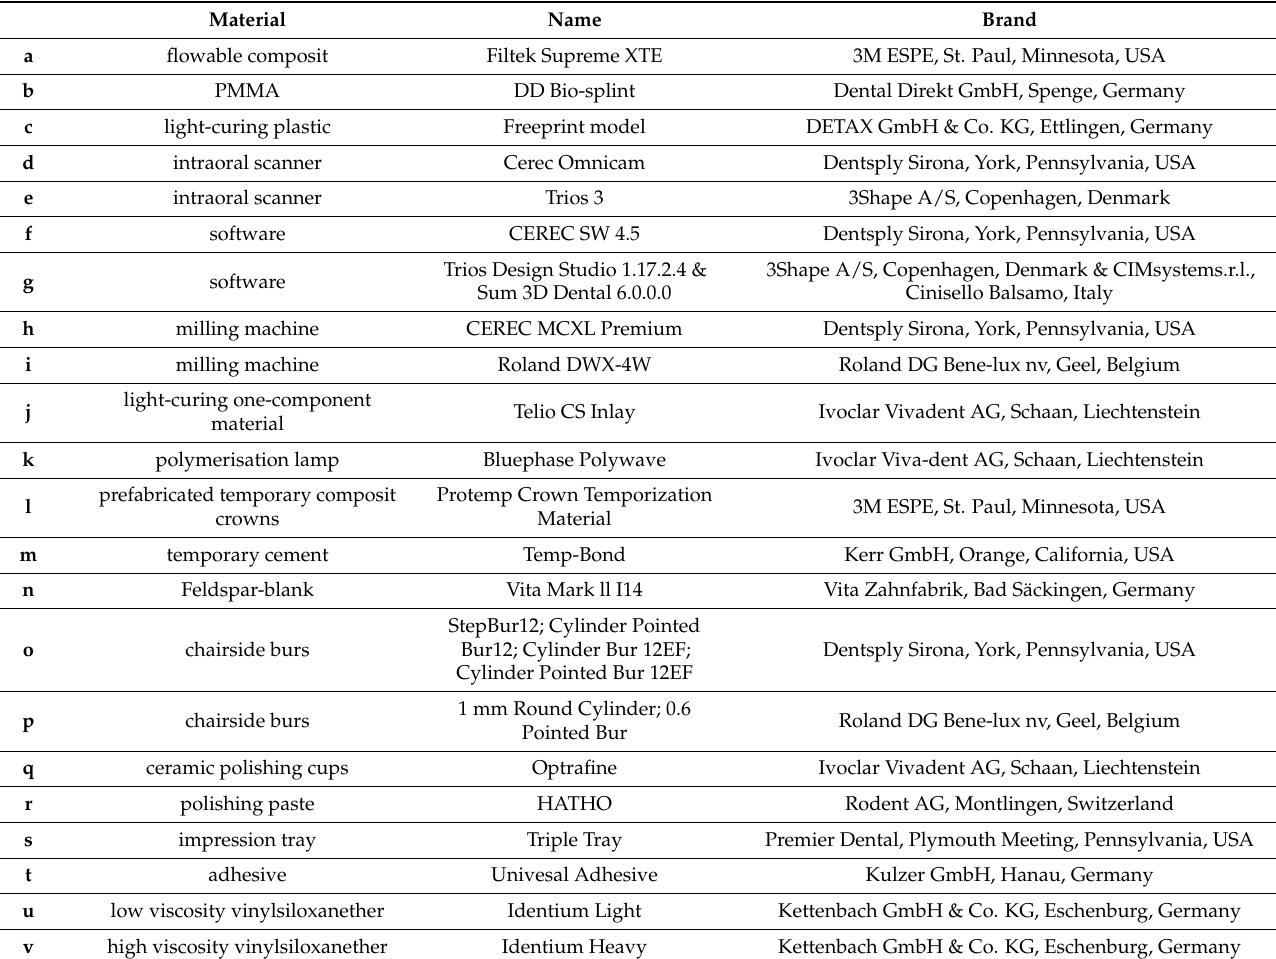
Table 1. Details for all used materials with name and